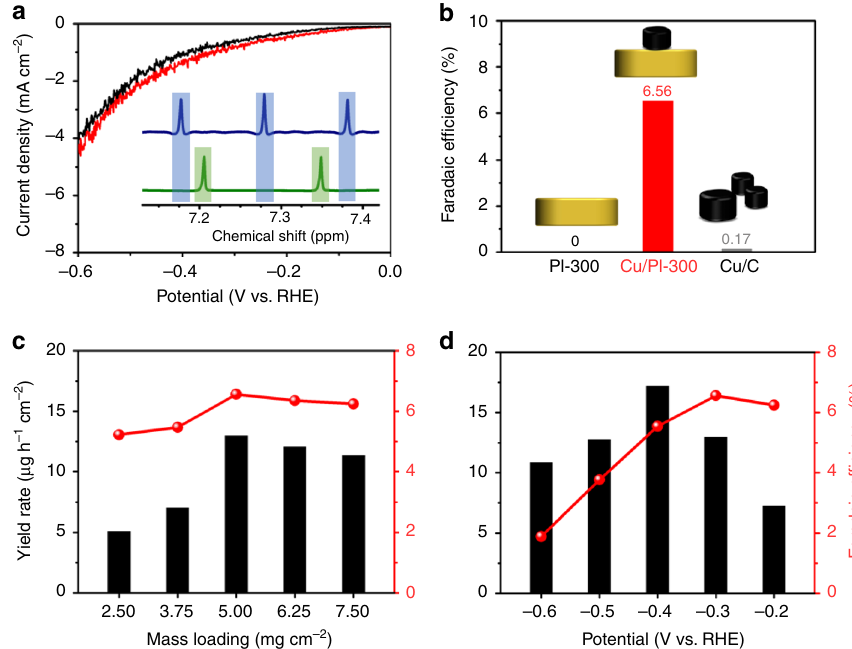
Fig. 2 N 2 reduction reaction performance of the electrocatalysts. a The linear sweep voltammogram (LSV) curves of Cu/PI-300 (catalyst loading: 5 mg cm − 2 ) measured at a scan rate of 10 mV s − 1 under the Ar and N 2 atmosphere. b The Faradaic ef fi ciencies of bare PI-300, Cu/PI-300, and Cu/C for NH 3 generation at − 0.3 V vs. RHE within 6 h. The Faradaic ef fi ciencies (spheres) and NH 3 yield rates (bars) of Cu/PI-300 with varied catalyst loadings at − 0.3 V vs. RHE c or with a fi xed catalyst loading (5 mg cm − 2 ) at different work potentials d within 6 h. Insets: a 1 H NMR spectra of both 14 NH + produced from the NRR reaction using 14 N 15 NH 15 N 4 2 and 2 gas (Supplementary Fig. 26) directly con fi rm the negative effect of the electron-de fi ciency induced in the Cu nanoparticles on HER, which is, on the other hand, highly preferred for the improvement